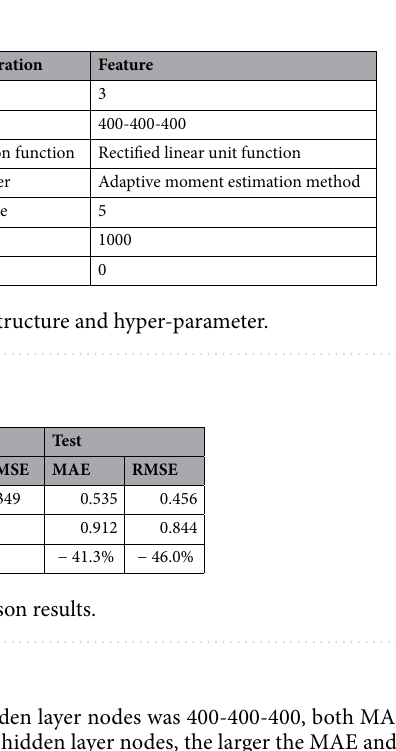
Table 5. As shown in Table 5, MAE and RMSE values of the validation data were 0.402 and 0.349, respectively. MAE and RMSE values of the test data were 0.535 and 0.456, respectively. Therefore, differences between values